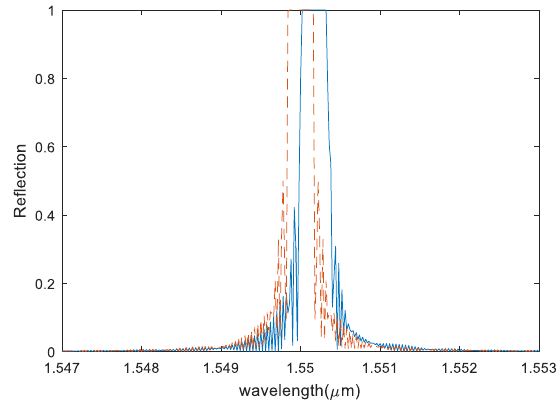
Figure 12: Initial structure (solid line) and structure with temperature offset removal (dash line) reflection response at 37